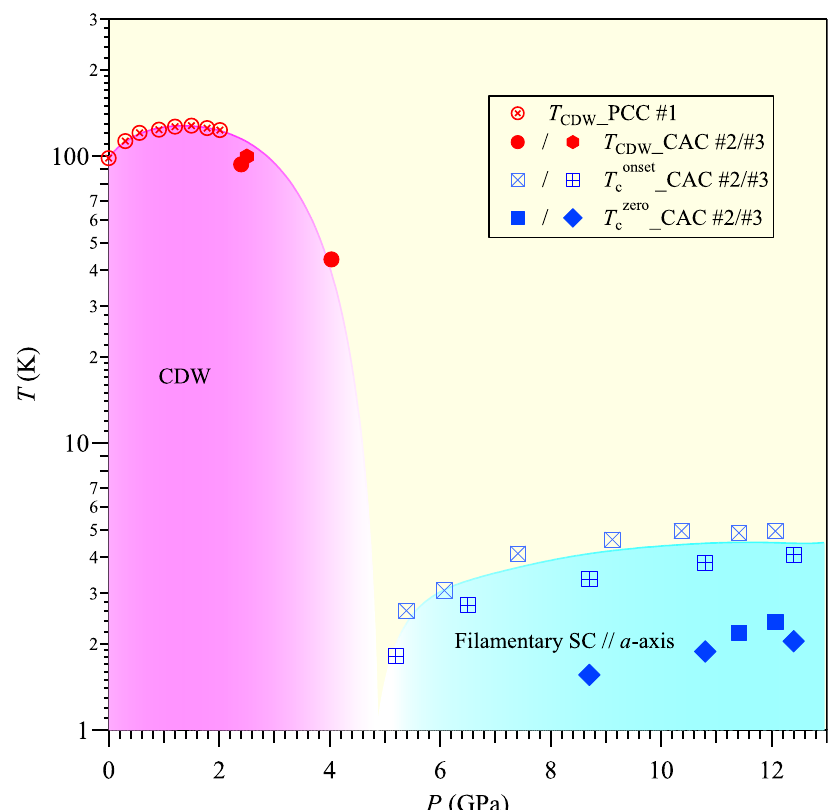
Fig. 6 Temperature-pressure phase diagram of HfTe 3 single crystal. Pressure dependences of the chage-density-wave transition temperature T CDW and the superconducting transition temperatures T conset and T czero determined from the resistance measurements along the a